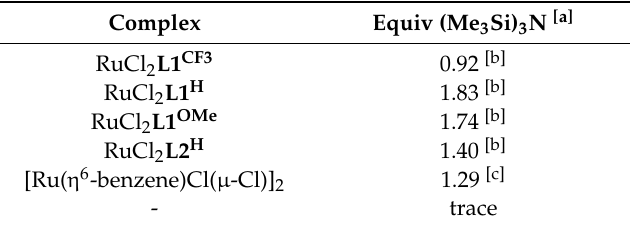
Table 3. Formation of (Me 3 Si) 3 N with RuCl 2 L